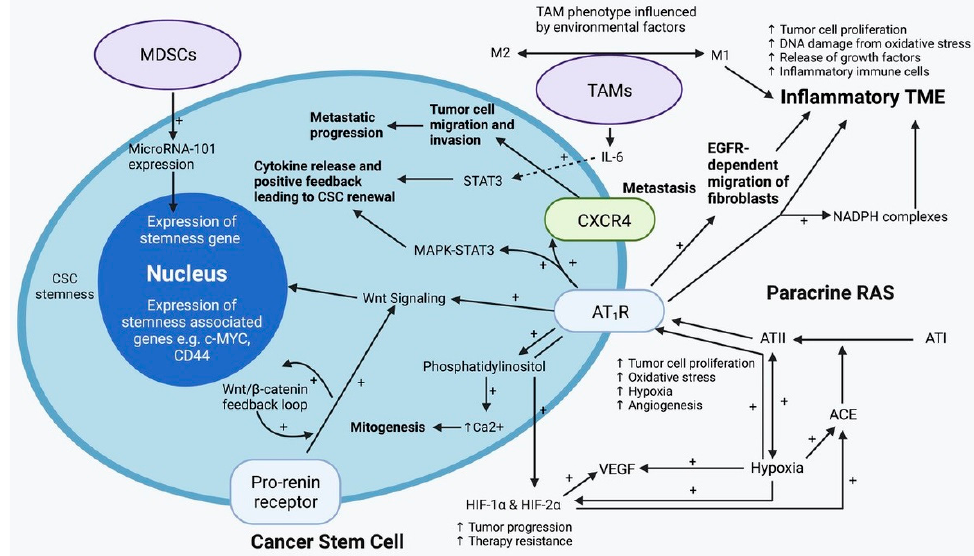
Figure 3. A cancer stem cell (CSC) residing within the tumor microenvironment (TME) which is regulated by the paracrine renin–angiotensin system (RAS) and the immune system. The active end ‐ product of the paracrine RAS—angiotensin II (ATII), activates ATII receptor 1 (AT 1 R) resulting in increased tumor cell proliferation, oxidative stress, hypoxia and angiogenesis, and inflammation—the hallmarks of cancer. This contributes to an inflammatory TME by increasing the number of inflammatory cells, partly by increasing the number of NADPH complexes, leading to tumor cell proliferation, DNA damage from oxidative stress, and release of growth factors. AT 1 R also activates phosphatidylinositol signaling which increases cytosolic Ca2+ to promote mitogenesis. Hypoxia increases paracrine RAS activity by up ‐ regulating angiotensin ‐ converting enzyme (ACE) and hypoxia ‐ inducible factor 1 α (HIF ‐ 1 α ) and HIF ‐ 2 α expression, which increase tumor progression and treatment resistance. HIF ‐ 1 α , HIF ‐ 2 α , and hypoxia also increase the expression of vascular endothelial growth factor (VEGF) which promotes angiogenesis. Binding of AT 1 R to C ‐ X ‐ C chemokine receptor type 4 (CXCR4) promotes tumor cell migration and invasion, leading to metastatic spread. AT 1 R, via MAPK ‐ STAT3 signaling, contributes to a cytokine release that leads to CSC renewal. AT 1 R signaling also contributes to the migration of fibroblasts in an epidermal growth factor receptor (EGFR) ‐ dependent fashion. AT 1 R signaling and the pro ‐ renin receptor, acting in a feedback loop with Wnt/ β‐ catenin, increase Wnt signaling which promotes CSC stemness by up ‐ regulating stemness ‐ associated markers. Myeloid ‐ derived suppressor cells (MDSCs) promote CSC characteristics by increasing the expression of microRNA ‐ 101 that induces expression of stemness ‐ related genes in CSCs. Under the influence of the TME, polarization of tumor ‐ associated macrophages (TAMs) within the TME, changes from the M1 to M2 phenotype. M2 TAMs induce the proliferation of CSCs via interleukin ‐ 6 (IL ‐ 6) ‐ induced activation of STAT3, leading to cytokine release and positive feedback that contribute to CSC renewal. Abbreviations: ATI, angiotensin I; AT 2 R, ATII receptor 2; Ang1–7, angiotensin 1–7; ATIII, angiotensin III; MAPK, mitogen ‐ activated protein kinase. Adapted from the Journal of Histochemistry and Cytochemistry [90]. Diagram recreated with BioRender.com, accessed on 1 November 2022.